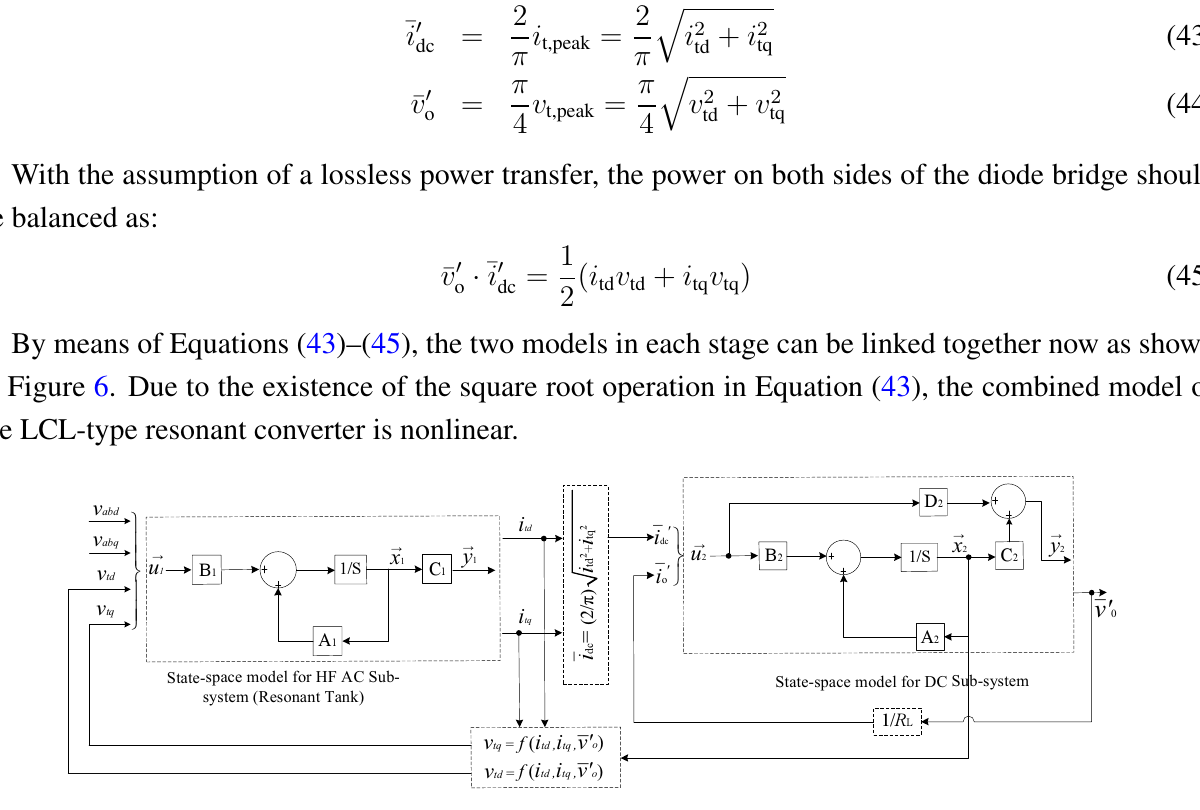
Figure 6. A nonlinear model of LCL-type resonant dc/dc